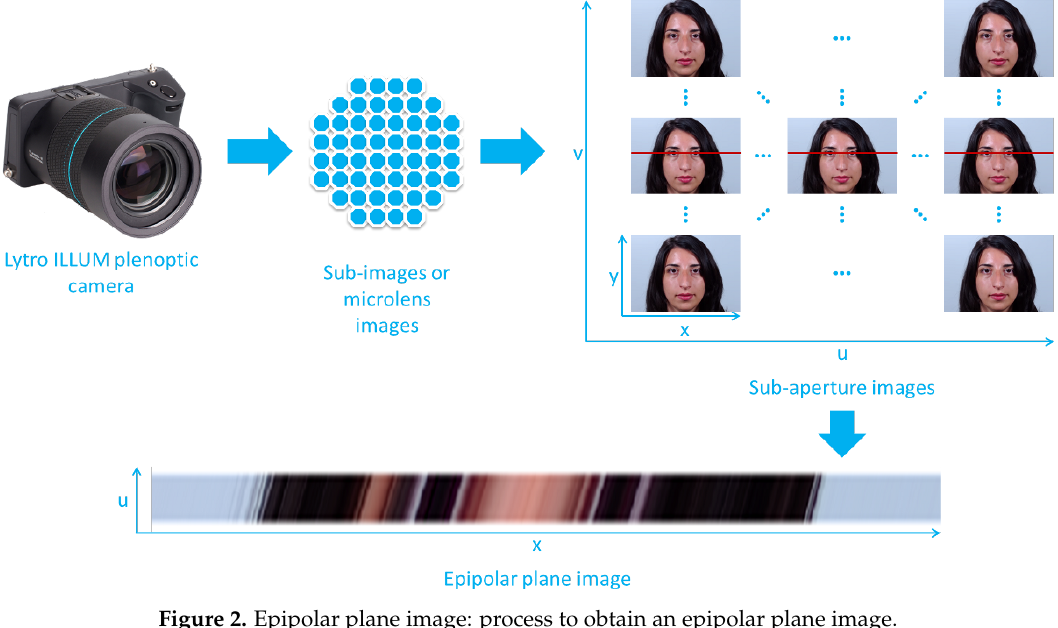
Figure 2. Epipolar plane image: process to obtain an epipolar plane image.